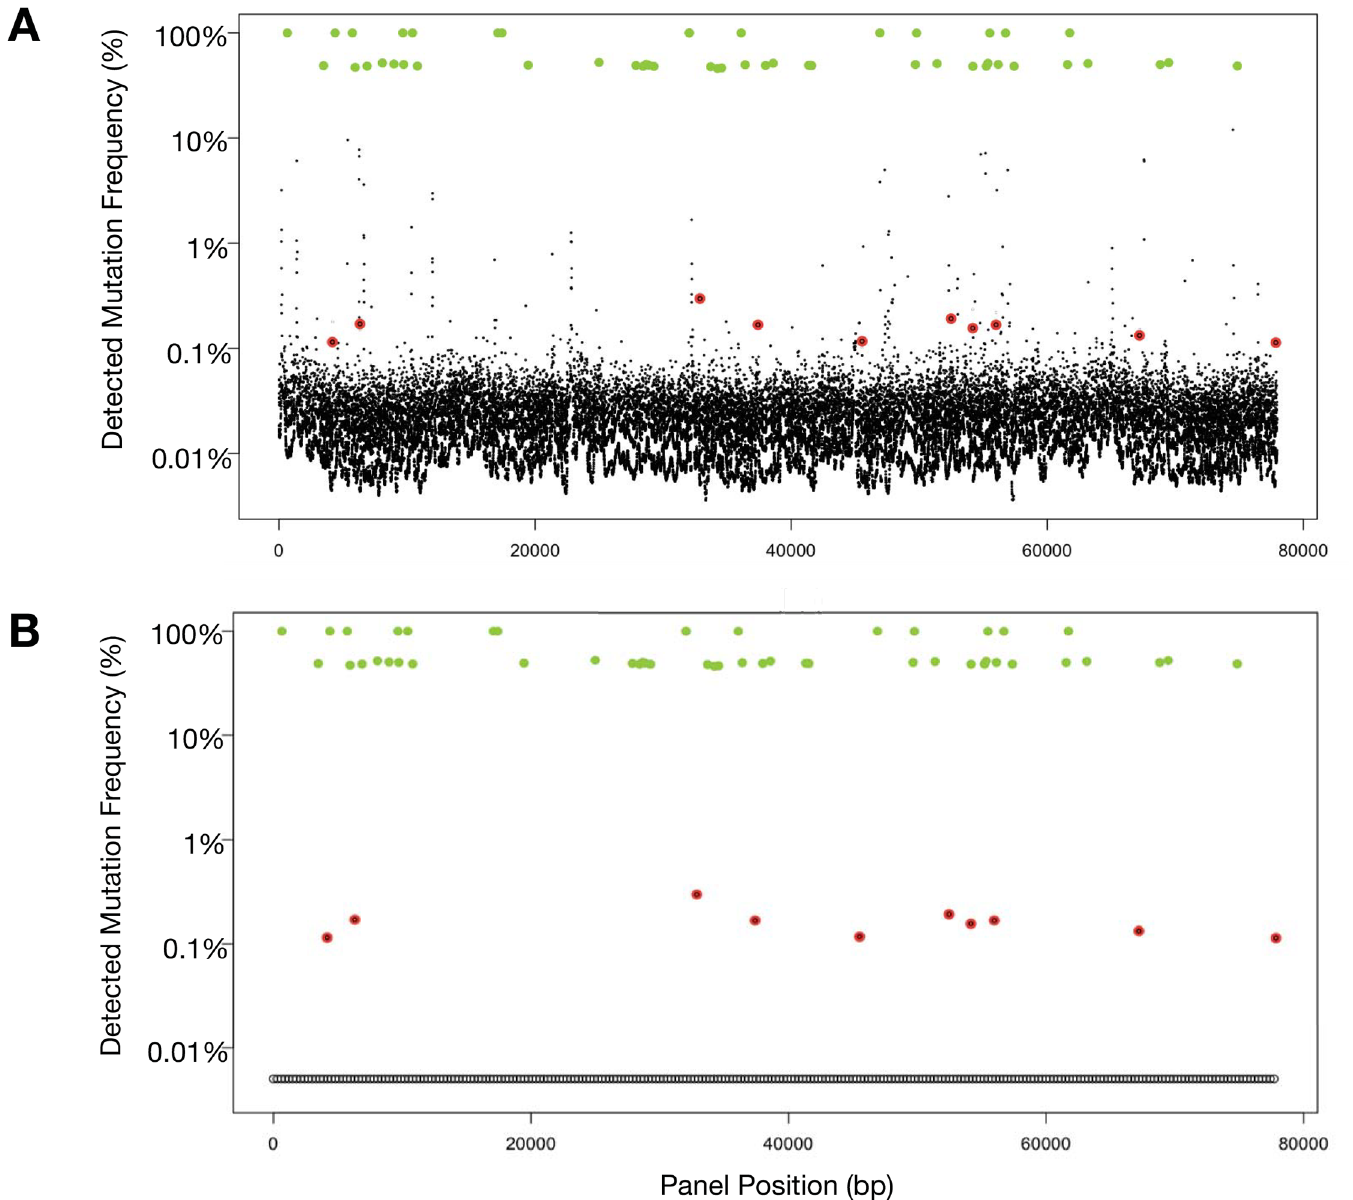
Fig 2. Fig 2A illustrates output from Illumina HiSeq using standard library prep on cell-free DNA sample spiked with samples from ten cell lines with known single nucleotide variant (SNV) mutations. Germline single nucleotide polymorphisms (SNPs) (green dots) at either 50% (heterozygous) or 100% (homozygous) mutant allele fractions (MAF). In contrast, the ten somatic SNVs (red dots) are quantitated at much lower MAF typically encountered with cell-free circulating tumor DNA, and are obscured by the false positive “ noise ” associated with low DNA concentrations. The larger the targeted region, the more false positive signals are encountered. In this actual sample, sequencing the long targeted region (78 kbp) required for the 54-gene panel results in 224 false positives at the 0.1% to 10% MAFs, making accurate sequencing of ctDNA unworkable. Fig 2B utilizes the same sample as in Fig 2A but was analyzed with Digital Sequencing technology. Molecular techniques in the pre-analytic/pre-sequencing phase and bioinformatics in the post-sequencing phase are employed to eliminate the “ noise ” in a process analogous to the signal transduction processing-enabled conversion of analog voice and television signals to digital signals. The result is sensitivity to the level of 1 – 2 mutated DNA fragment molecules in up to 1,000 wild type (mostly leukocyte-derived) DNA fragments overlapping the same nucleotide base position, essentially eliminating the false positives normally encountered at low MAFs when sequencing large targeted